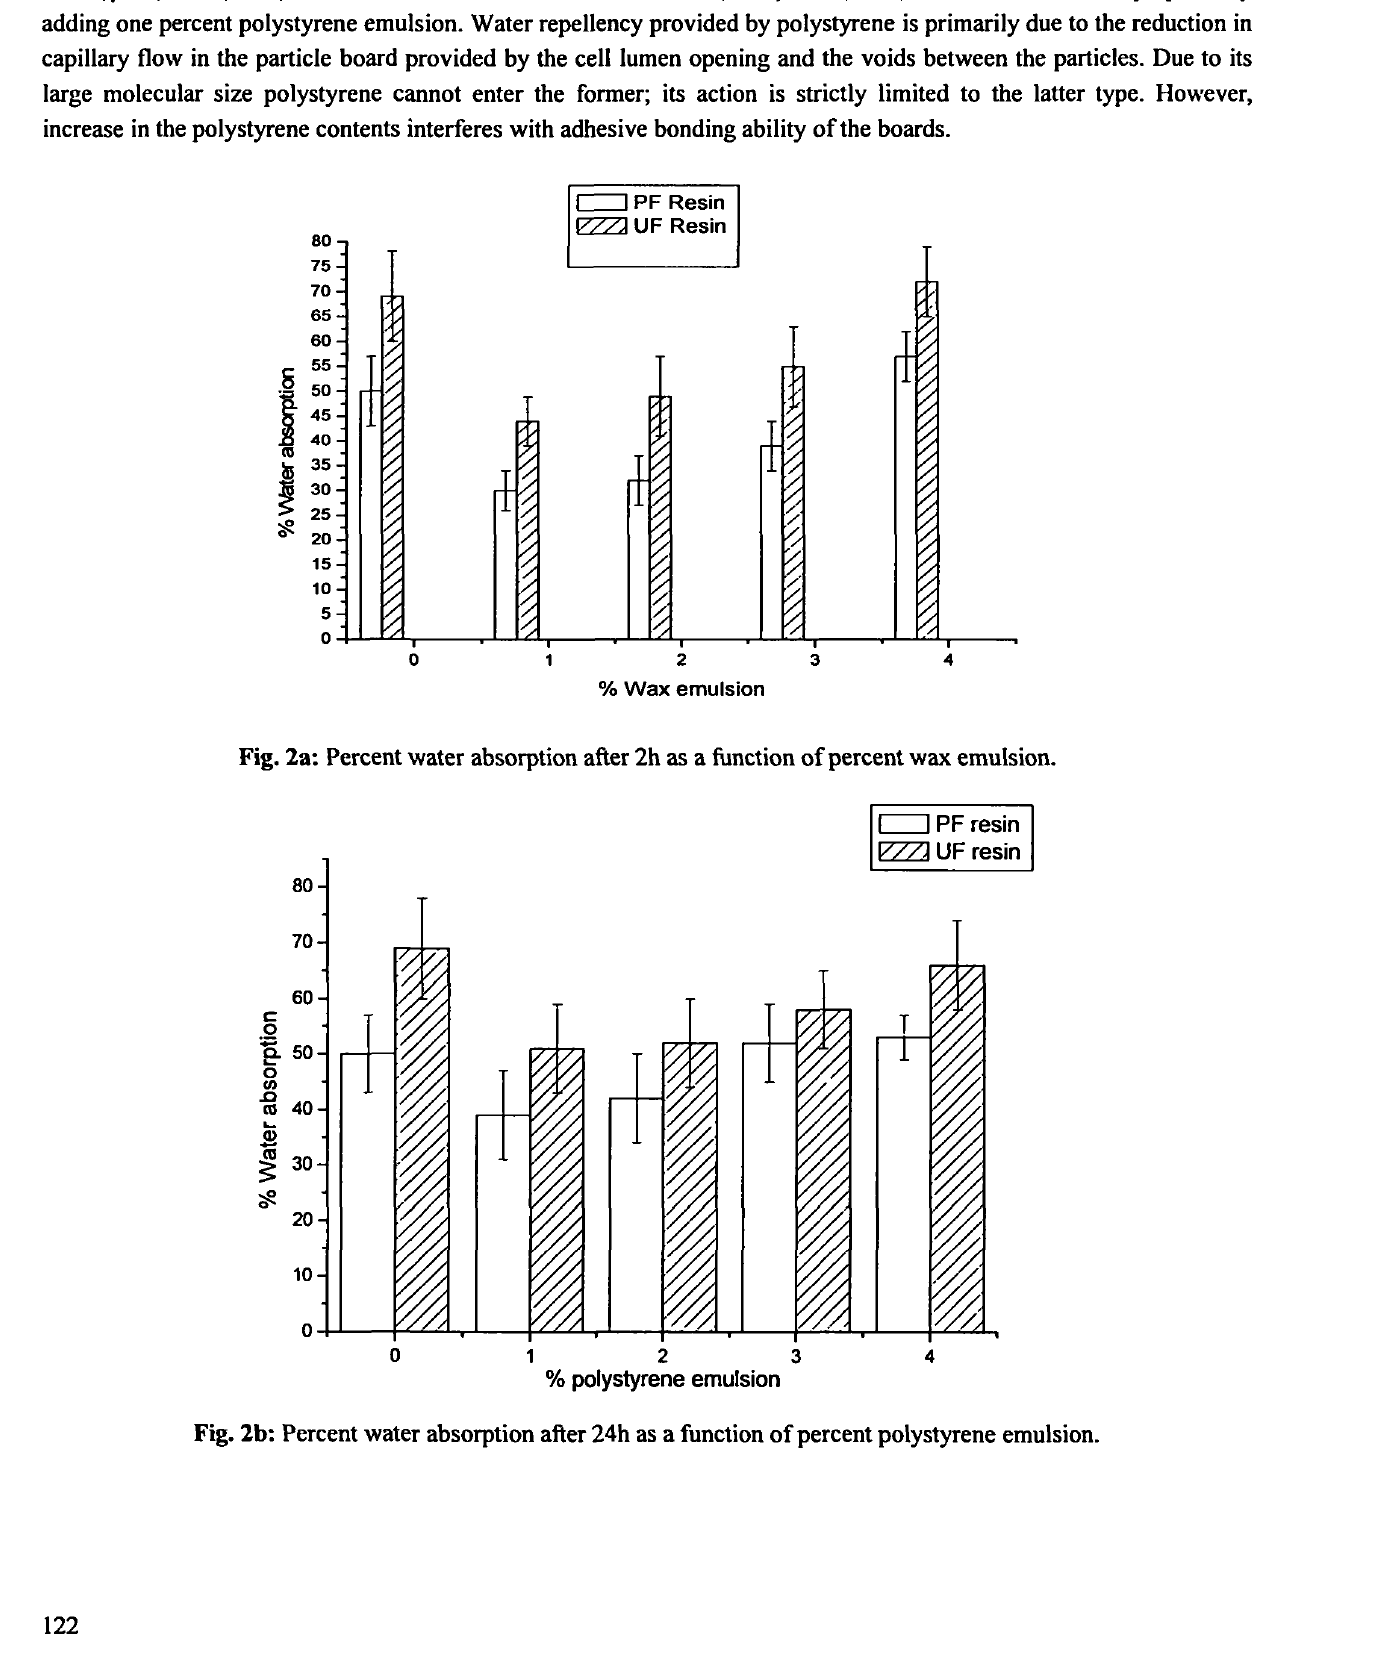
Fig. 2a: Percent water absorption after 2h as a function of percent wax emulsion.